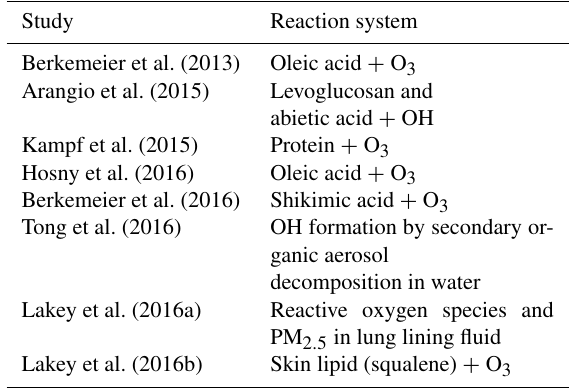
Table 1. Previous studies applying the MCGA.